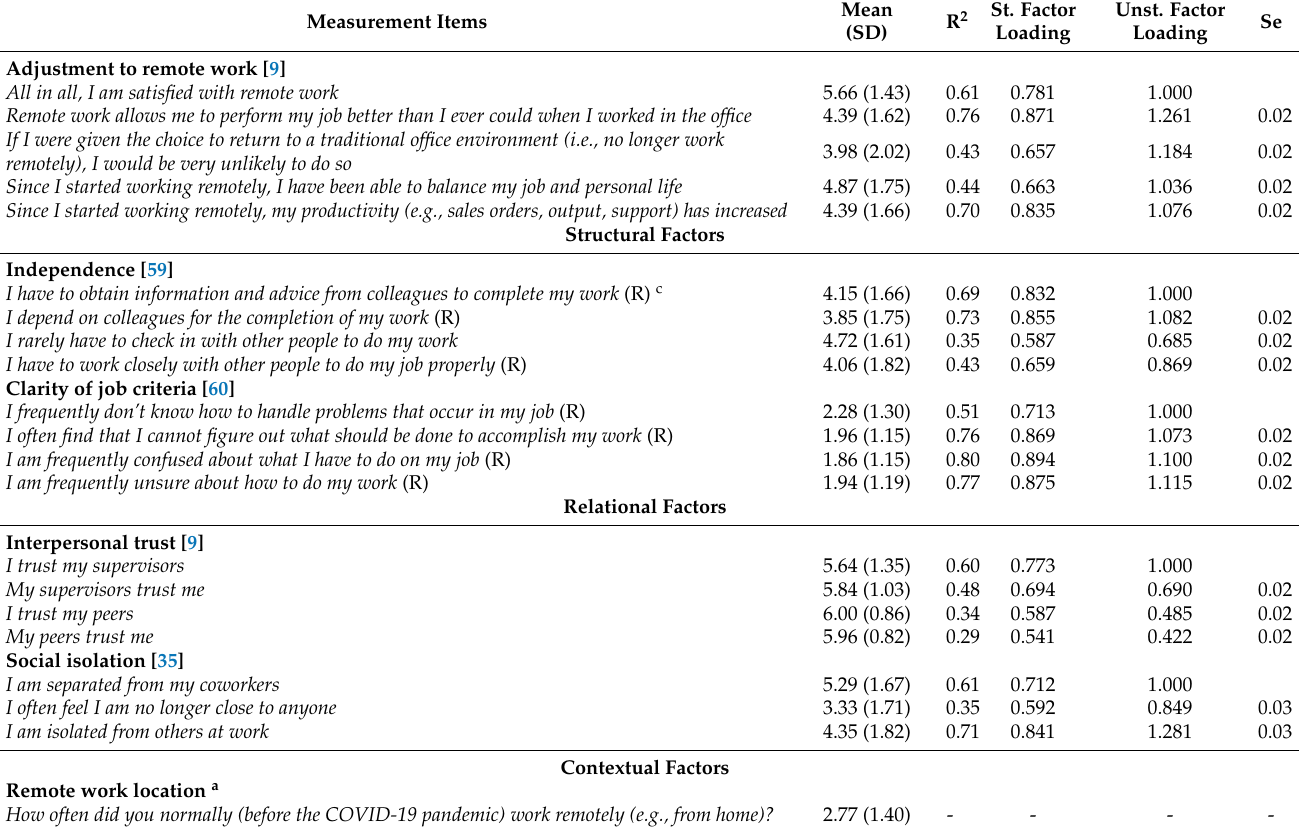
Table 1. Measurement items and descriptive